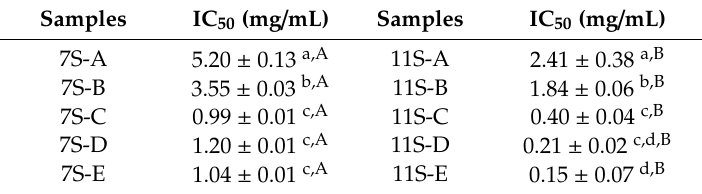
Table 2. Angiotensin convert enzyme (ACE) inhibitory capacity of the 7S and 11S